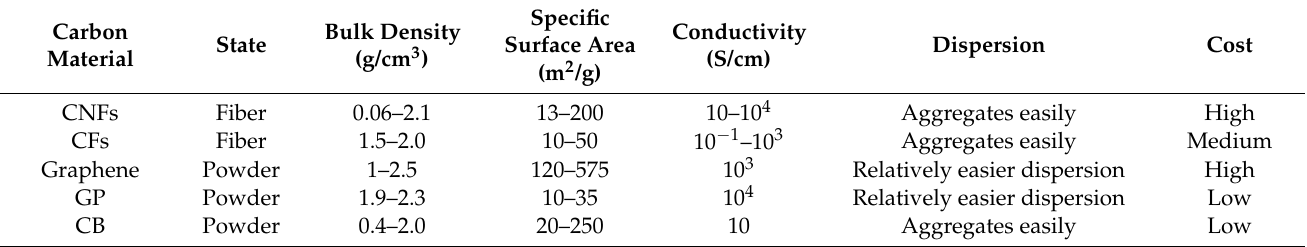
Table 1. General properties of carbon materials